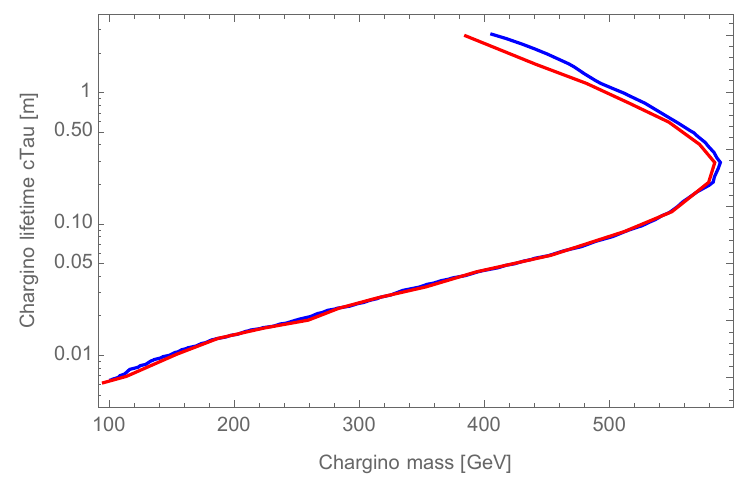
Figure 10 . Exclusion limit at 95% CL for the supersymetric pure-wino chargino/neutralino analysis obtained from ref. [61] (red) and by using the recasting of the e(cid:14)ciencies as explained in the text